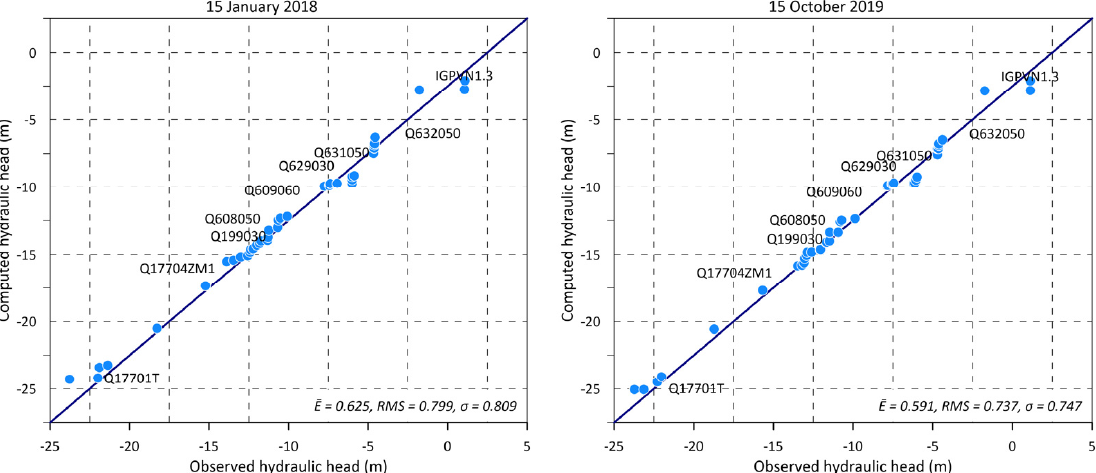
Figure 8. The comparison of computed vs. observed head values in January 2018 and October 2019.